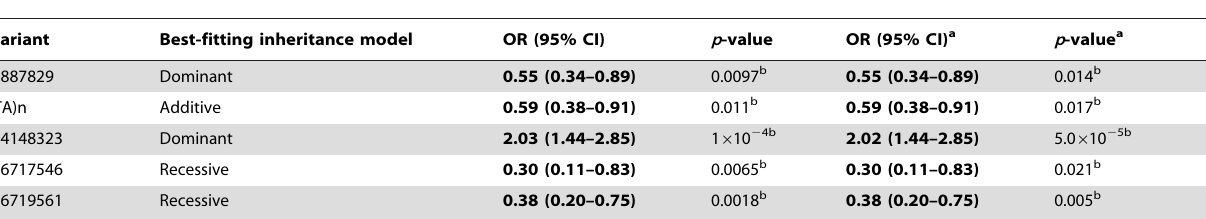
Table 5. Estimated effects of selected variants on